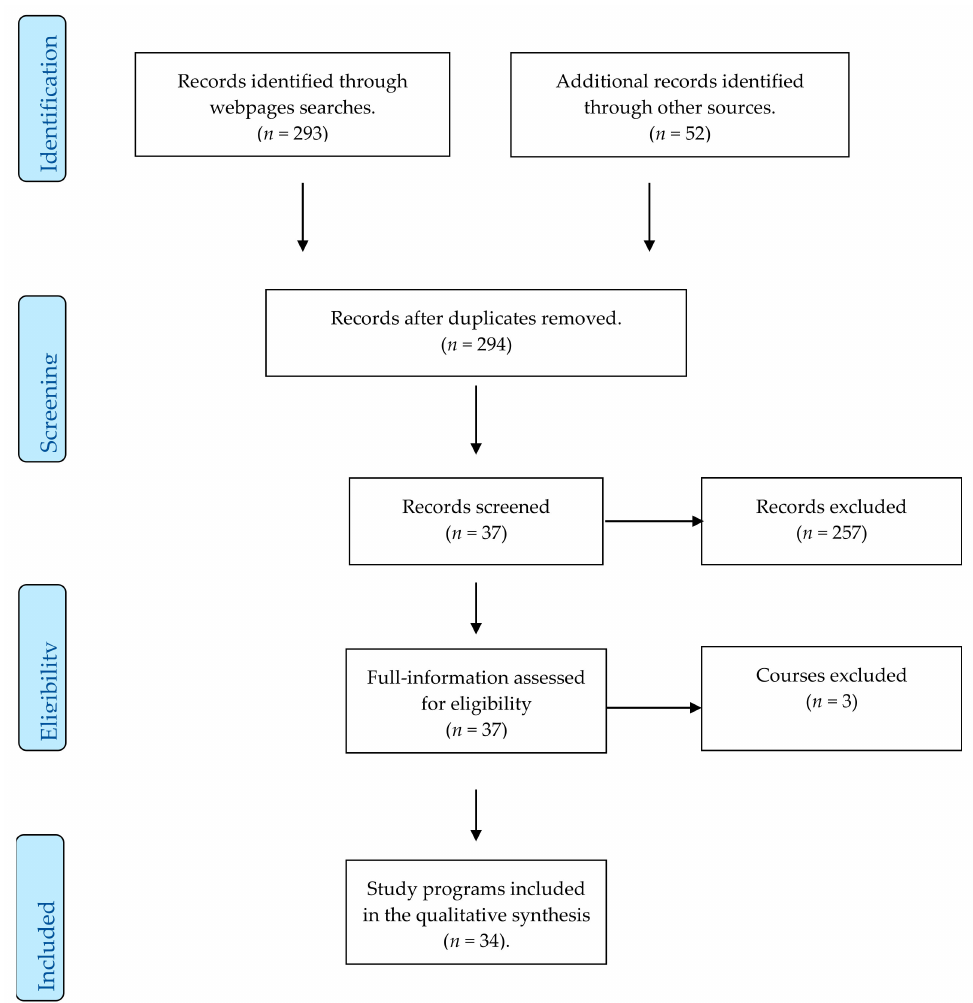
Figure 1. PRISMA flow diagram of the search